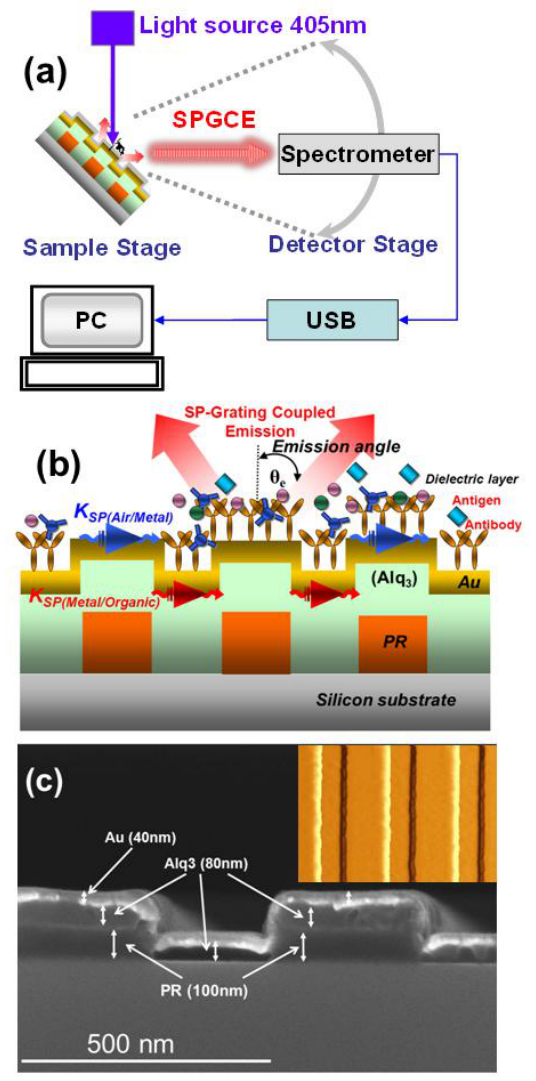
Figure 1. ( a ) Experimental setup of the measurement system, ( b ) schematic cross-section of the device, and ( c ) SEM and AFM (inset) images of the sample with grating pitch 500